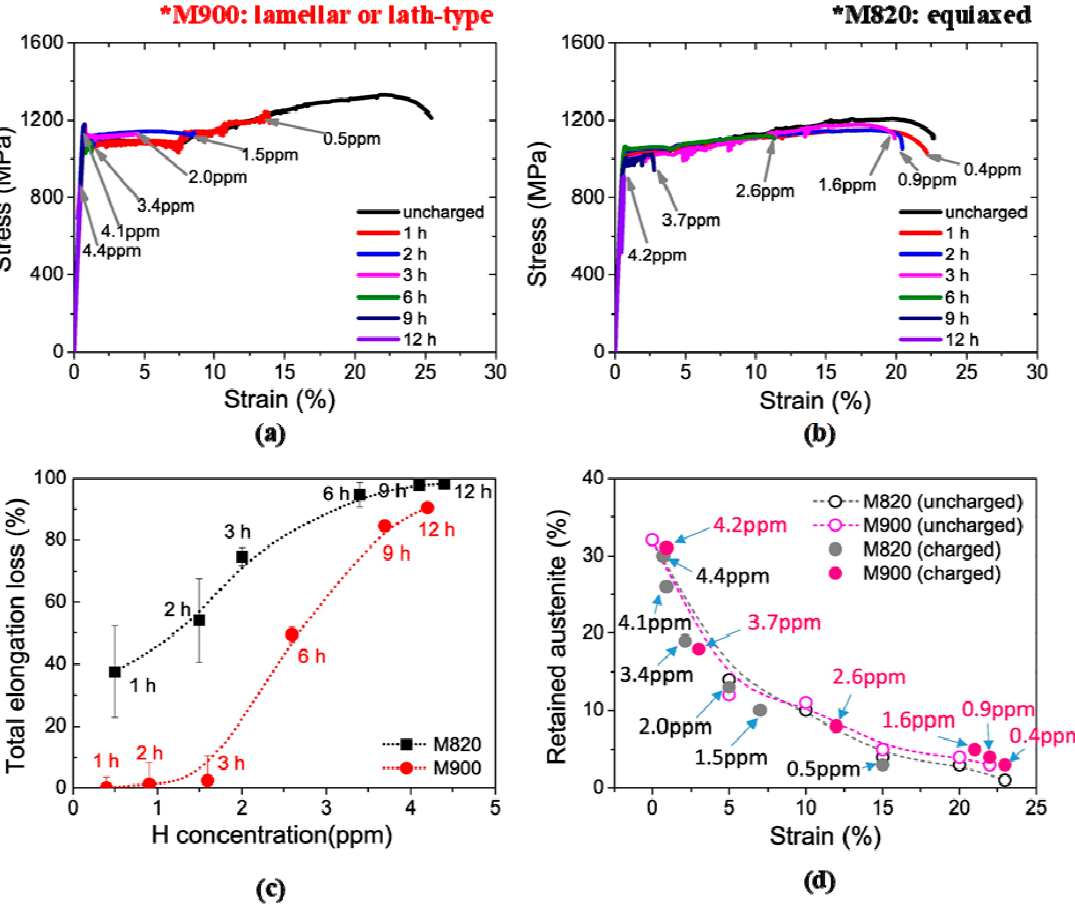
Figure 4. Effect of various H-charging conditions on SSRT properties of intercritically annealed medium-Mn steels (Fe–0.11C–7.2Mn–1.0Si, in wt pct) with ( a ) lamellarized (M900) and ( b ) equiaxed morphologies (M820). ( c ) H-induced elongation loss as a function of the diffusible H content. ( d ) Change of austenite fraction during tensile deformation. The specimen M900 was austenitized at 900 ◦ C for 10 min, cooled to room temperature, and reheated to an IA temperature of 650 ◦ C for 4 min. The specimen M820 was austenitized at 820 ◦ C for 10 min, cooled to room temperature, and reheated to an IA temperature of 650 ◦ C for 2 min. Reproduced from Reference [10], with permission from Elsevier.